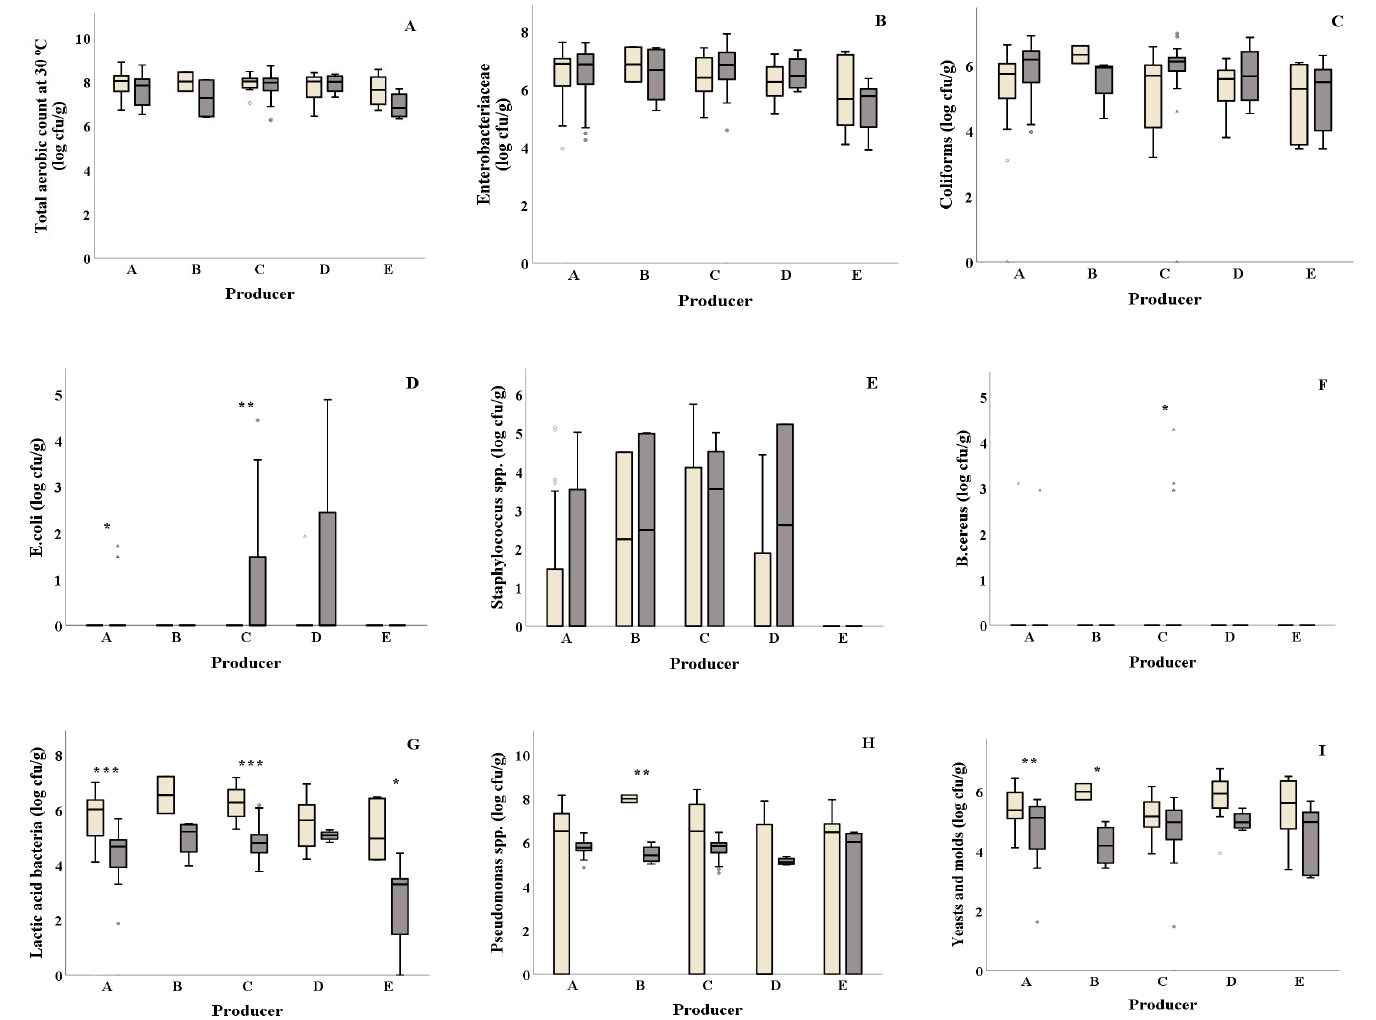
Figure 1. Effect of season on the microbiological quality ( A – I ) of ready-to-eat salads collected in winter ( Figure 1 . Effect of season on the microbiological quality ( A – I ) of ready-to-eat salads collected in winter ( ) and summer ( ) among salad producers/packagers (A, B, C, D, and E). Results include Figure 1 . Effect of season on the microbiological quality ( A – I ) of ready-to-eat salads collected in winter ( ) and summer ( ) among salad producers/packagers (A, B, C, D, and E). Results include ) among salad producers/packagers ( A – E ). Results include all Figure 1 . Effect of season on the microbiological quality ( A – I ) of ready-to-eat salads collected in winter ( ) and summer ( ) among salad producers/packagers (A, B, C, D, and E). Results include all samples for each microorganism tested and are the mean value ± standard deviation. Each box contains 50 percent of cases, and whiskers represent the rest. The line across the inside of the box all samples for each microorganism tested and are the mean value ± standard deviation. Each box contains 50 percent of cases, and whiskers represent the rest. The line across the inside of the box samples for each microorganism tested and are the mean value ± standard deviation. Each box contains 50 percent of cases, and whiskers represent the rest. The line across the inside of all samples for each microorganism tested and are the mean value ± standard deviation. Each box contains 50 percent of cases, and whiskers represent the rest. The line across the inside of the box represents the median value. *, ** and *** indicate significant differences at p ≤ 5%, 1% and 0.1%. represents the median value. *, ** and *** indicate significant differences at p ≤ 5%, 1% and 0.1%. the box represents the median value. *, ** and *** indicate significant differences at p ≤ 5%, 1% and represents the median value. *, ** and *** indicate significant differences at p ≤ 5%, 1% and 0.1%.